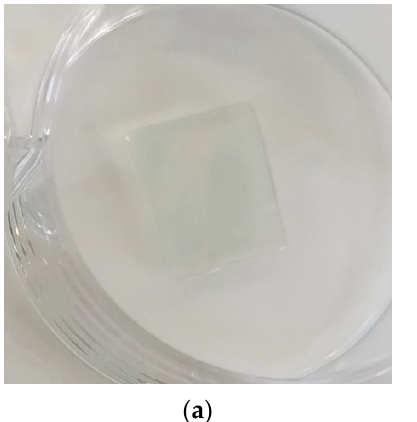
11 of 18 Figure 9. Electropherogram of a solution containing omalizumab (0.6 µM) and protein A (0.64 µM). Using the capillary electrophoresis data, the average value of the effective dissocia- tion constant of the 1:1 complex was determined, at Kd = (5.1 ± 2.1) × 10 − 7 (pKd = 6.3). Thus, the formation of a complex between omalizumab and protein A was demonstrated, which proved its further application for quality control of biosensor substrates and the sensitiv- ity of the formed nanostructured biosensor element.